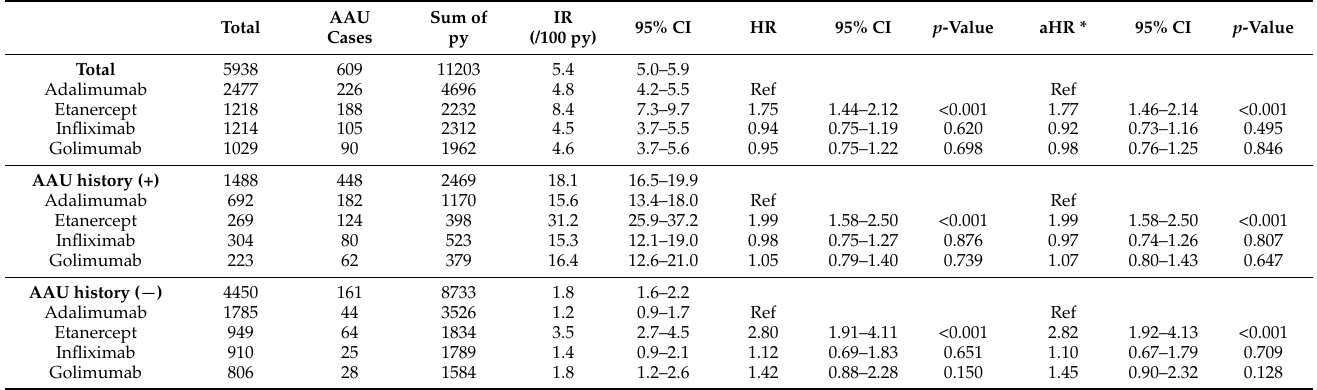
Table 3. The risk of the first AAU occurrence within 2 years of initiation of each TNF- α